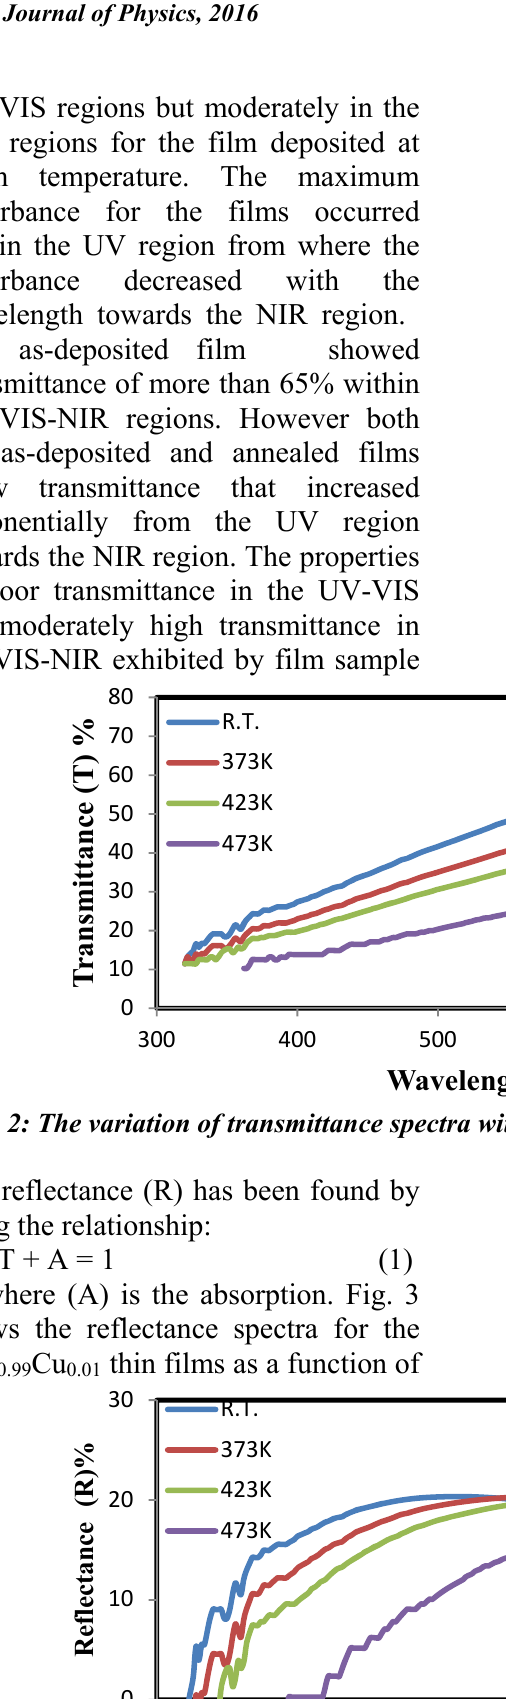
Fig. 3: The variation of reflectance spectra with wavelength for NiO